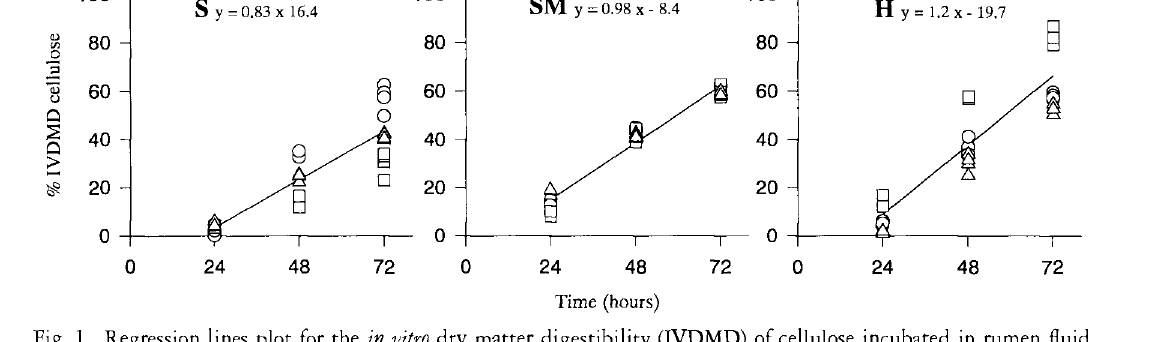
Fig. 1. Regression lines plot for the in vitro dry matter digestibility (IVDMD) of cellulose incubated in rumen fluid from reindeer fed regrowth timothy (Phlmm pratense) silage (S) (Animal S1 =0, S2 =D, S3 =A), silage mixed with molasses (SM) (Animal SM1 =0, SM2 =[TJ, SM3 =A) and hay (H) (Animal H1 =0, H2 =D, H3 =A) as a funtion of time.